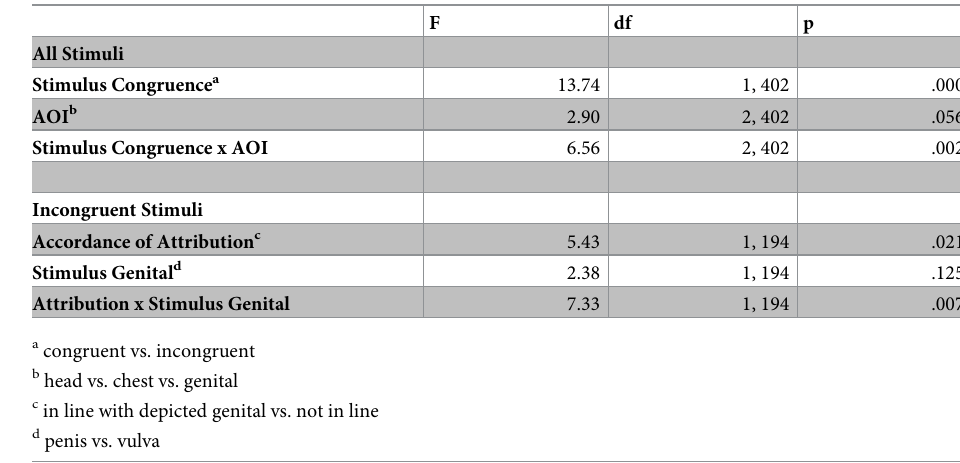
Table 5. Influences on dwell